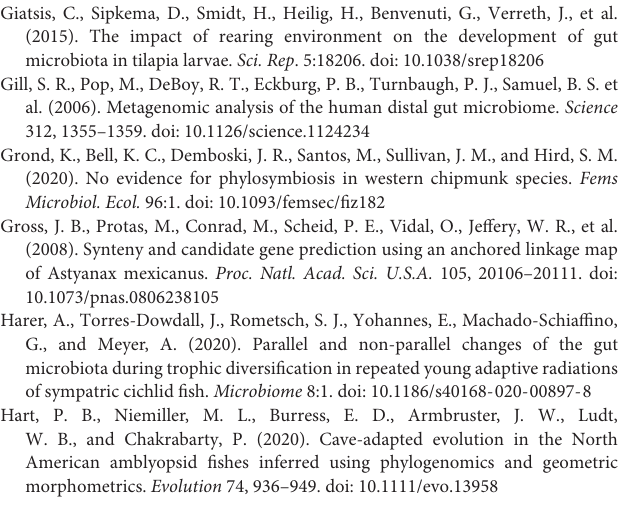
Supplementary Table 9 | Pathway information annotated the MetaCyc Metabolic Pathway Database. Supplementary Table 10 | Ten core microbiome of Sinocyclocheilus and their